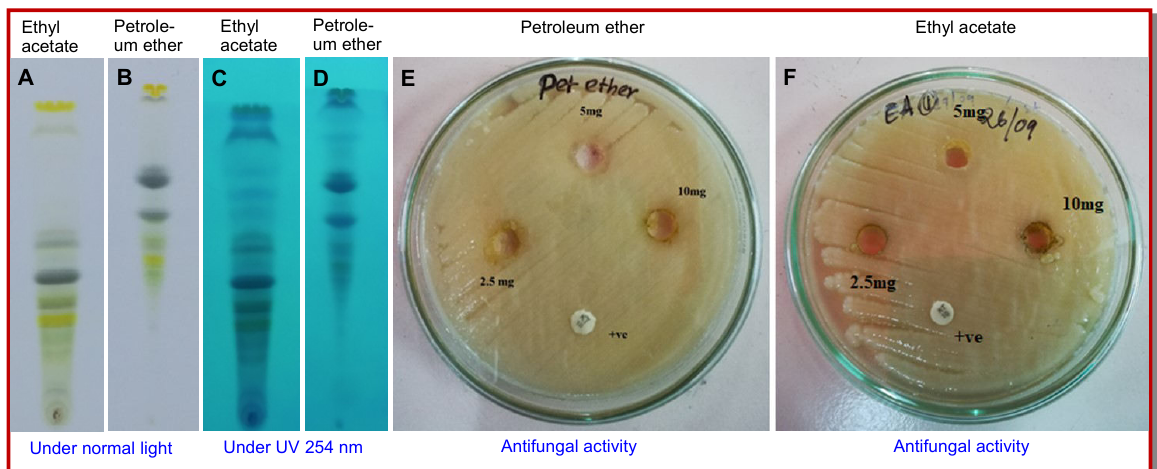
Figure 2: TLC sheet of the ethyl acetate and petroleum ether extracts (A-D); Antifungal activity of petroleum ether and ethyl ace- tate extracts (E,F)